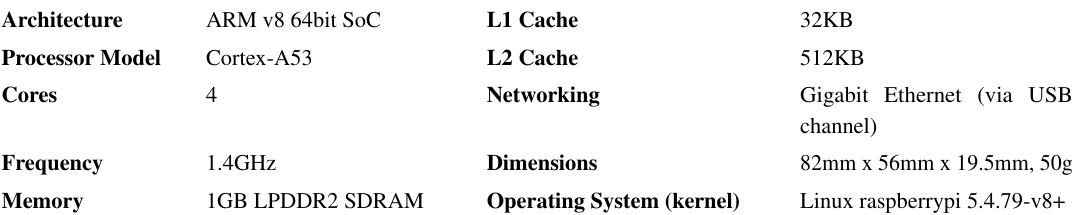
Table 1. Hosts specifications